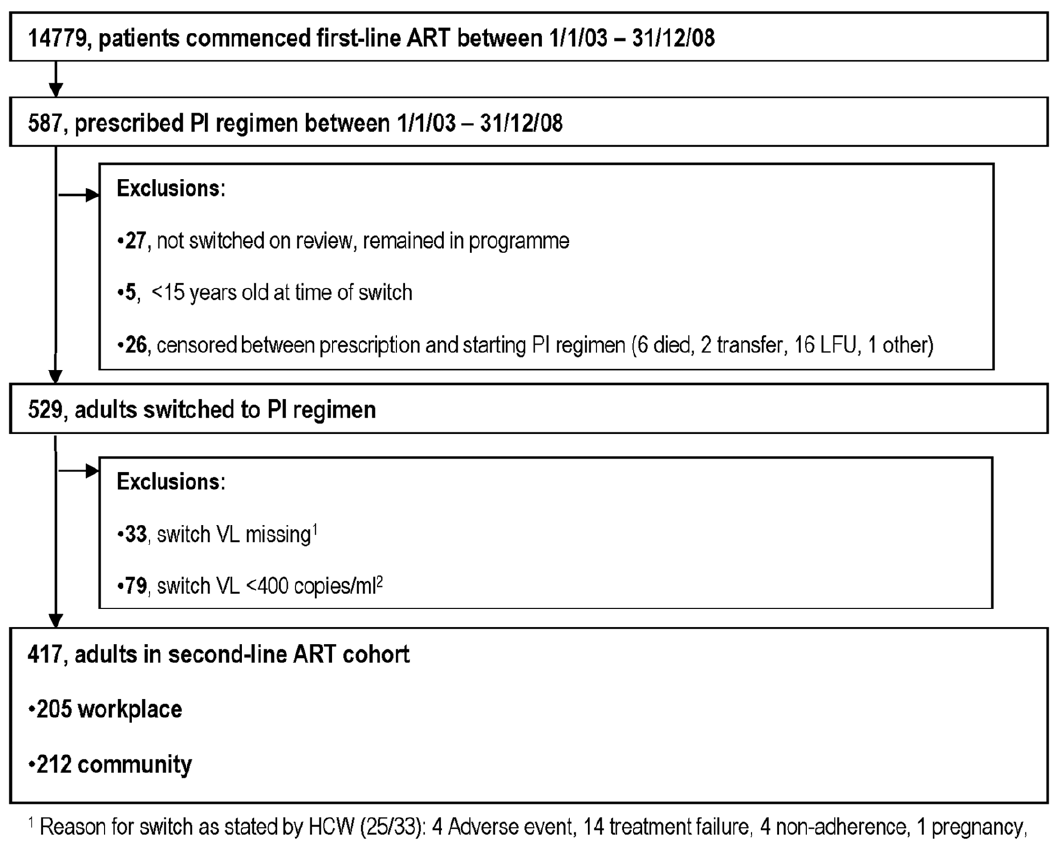
Figure 1. Study Flow diagram. Selection of adults for analysis, from a cohort of patients initiating first-line, NNRTI-based, ART between the 1 st January 2003 and 31 st December 2008.